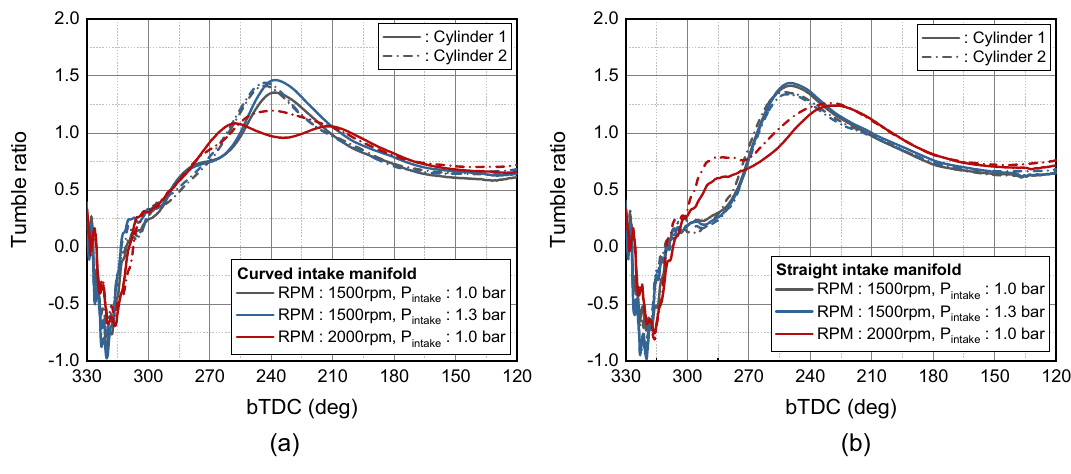
Figure 16. Tumble ratio during intake process: ( a ) curved manifold, ( b ) straight